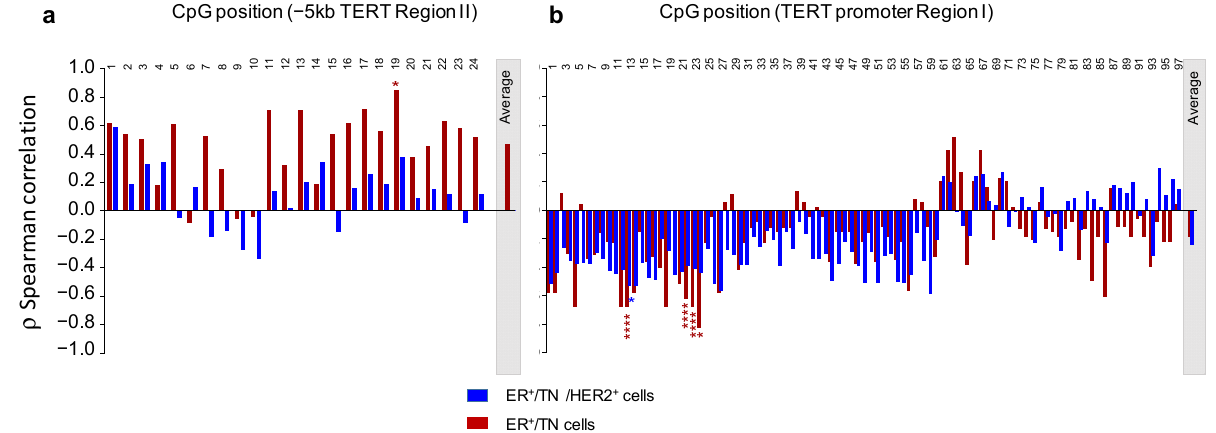
CpGposition (TERT promoterRegionI)CpGposition (−5kb TERT RegionII)